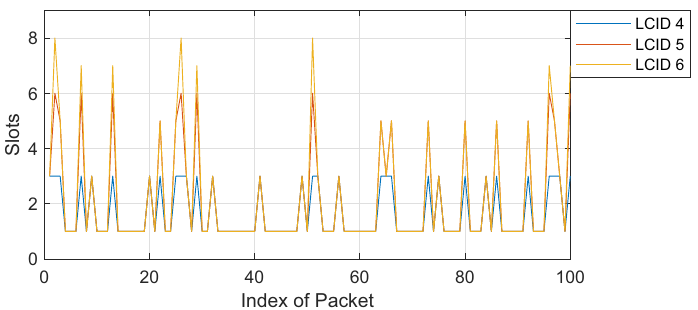
Figure 7. Arrival slots of the TSN traffic classes with static LCP.